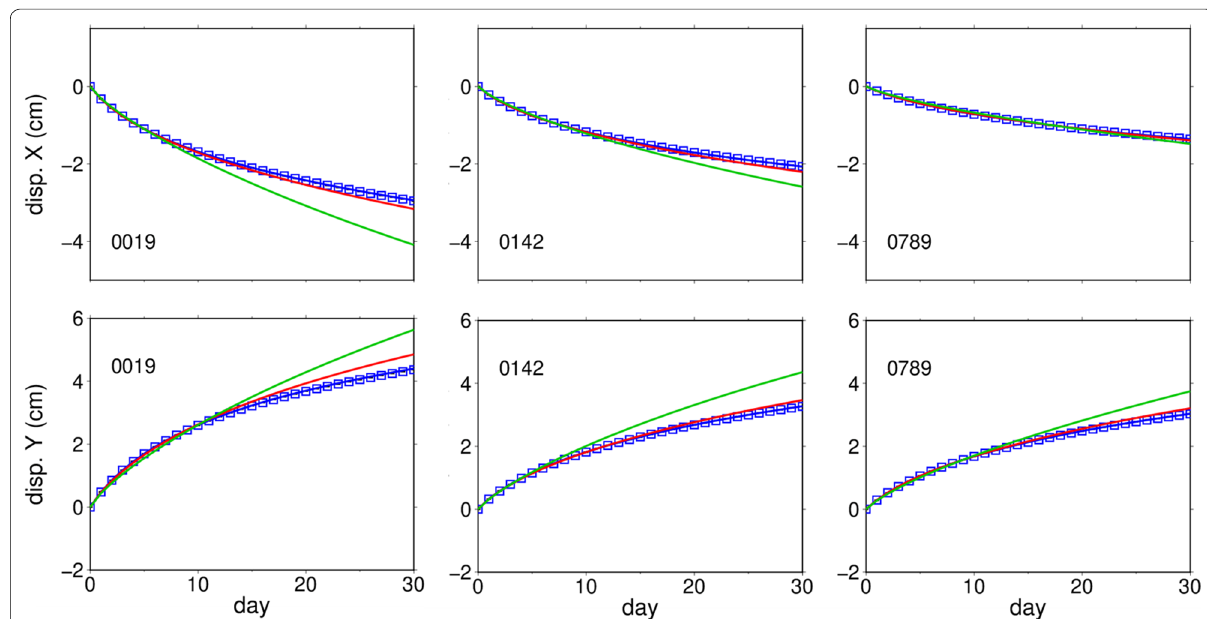
Fig. 16 Examples of postseismic time series in the numerical experiments. Blue squares indicate the noise-free synthetic data. Blue, red, and green lines are the theoretical time series calculated using the optimum frictional parameters in Exps. 1, 1-i and 1-ii, respectively. The locations of the GNSS stations are indicated in Fig.